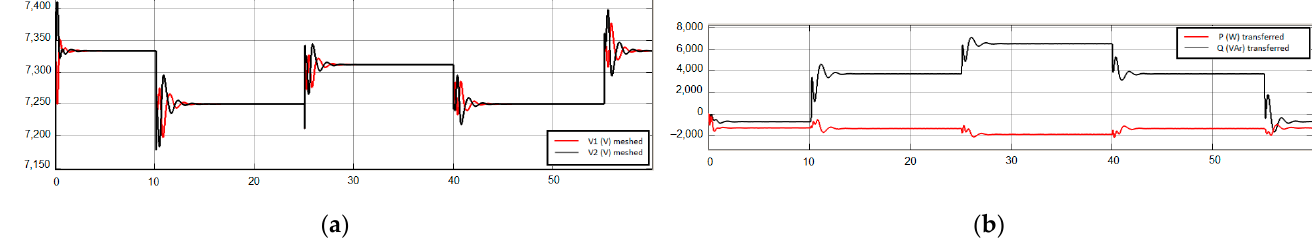
Figure 19. Simulation results of phase-to-ground terminal voltages behavior and the power flow with the converter operation; ( a ) V 1 and V 2 ; ( b ) transferred P and Q.